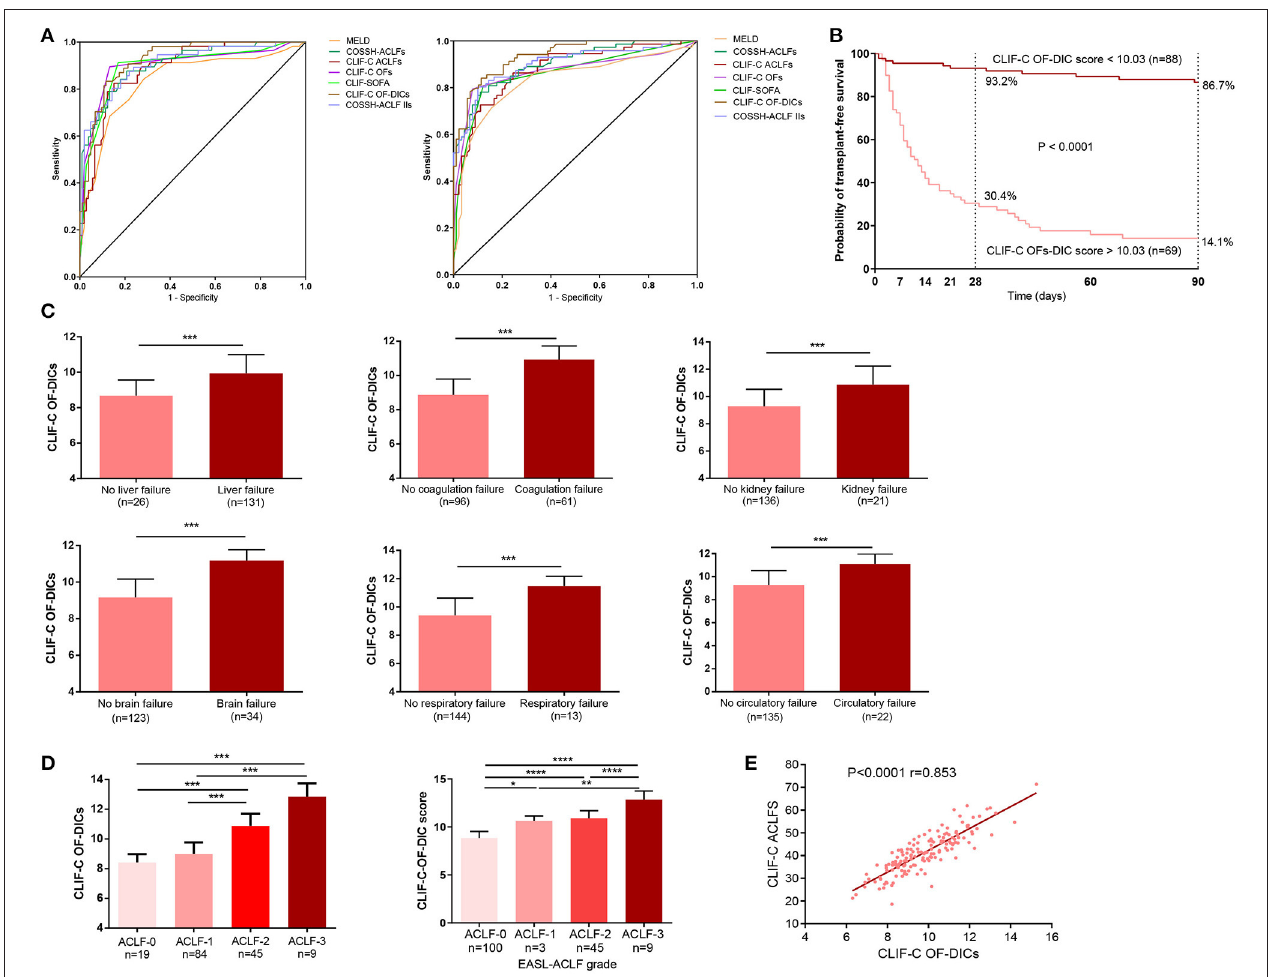
FIGURE 4 | Seven prognostic models used to predict the 28- and 90-day mortality of patients and the correlation between CLIF-C OF DICs and disease severity. (A) Accuracy of the CLIF-OF C-DICs as compared to MELDs, COSSH-ACLFs, CLIF-C ACLFs, CLIF-C OFs, CLIF-SOFA, and COSSH-ACLF-IIs in predicting 28-day (left) and 90-day (right) mortality of ACLF patients. The areas under the receiver operating curve were as follows. For 28-day mortality: CLI-C OF-DICs, 0.924; CLIF C-OFs, 0.900; CLIF-C ACLFs, 0.888; CLIF-SOFA, 0.895; MELD, 0.836; COSSH-ACLFs, 0.904; COSSH-ACLF-IIs, 0.905. For 90-day mortality: CLI-C OF-DICs: 0.936; CLIF C-OFs, 0.870; CLIF-C ACLFs, 0.879; CLIF-SOFA, 0.863; MELD, 0.830; COSSH-ACLFs, 0.903; COSSH-ACLF-IIs, 0.901. (B) Probability of 28- and 90-day transplant-free survival in ACLF patients based on the CLIF-C OF-DICs cutoff value (10.03). Kaplan-Meier curves were compared using the log-rank test. (C) The CLIF-C OF-DICs between patients with organ failure or not. (D) The CLIF-C OF-DICs in patients with different ACLF grades. (E) The correlation between CLIF-C OF-DICs and CLIF-C ACLFs. ACLF, acute-on-chronic liver failure; DIC, disseminated intravascular coagulation; CLIF, Chronic Liver Failure; COSSH-ACLF, Chinese Group on the Study of Severe Hepatitis B-ACLF; EASL-ACLF, European Association for the Study of the Liver-ACLF; CLIF-SOFA score, CLIF-sequential organ failure assessment score; CLIF-C OF-DICs, a novel prognostic score based on age, DIC score, and CLIF-C OFs; MELD, Model for end-stage liver disease;